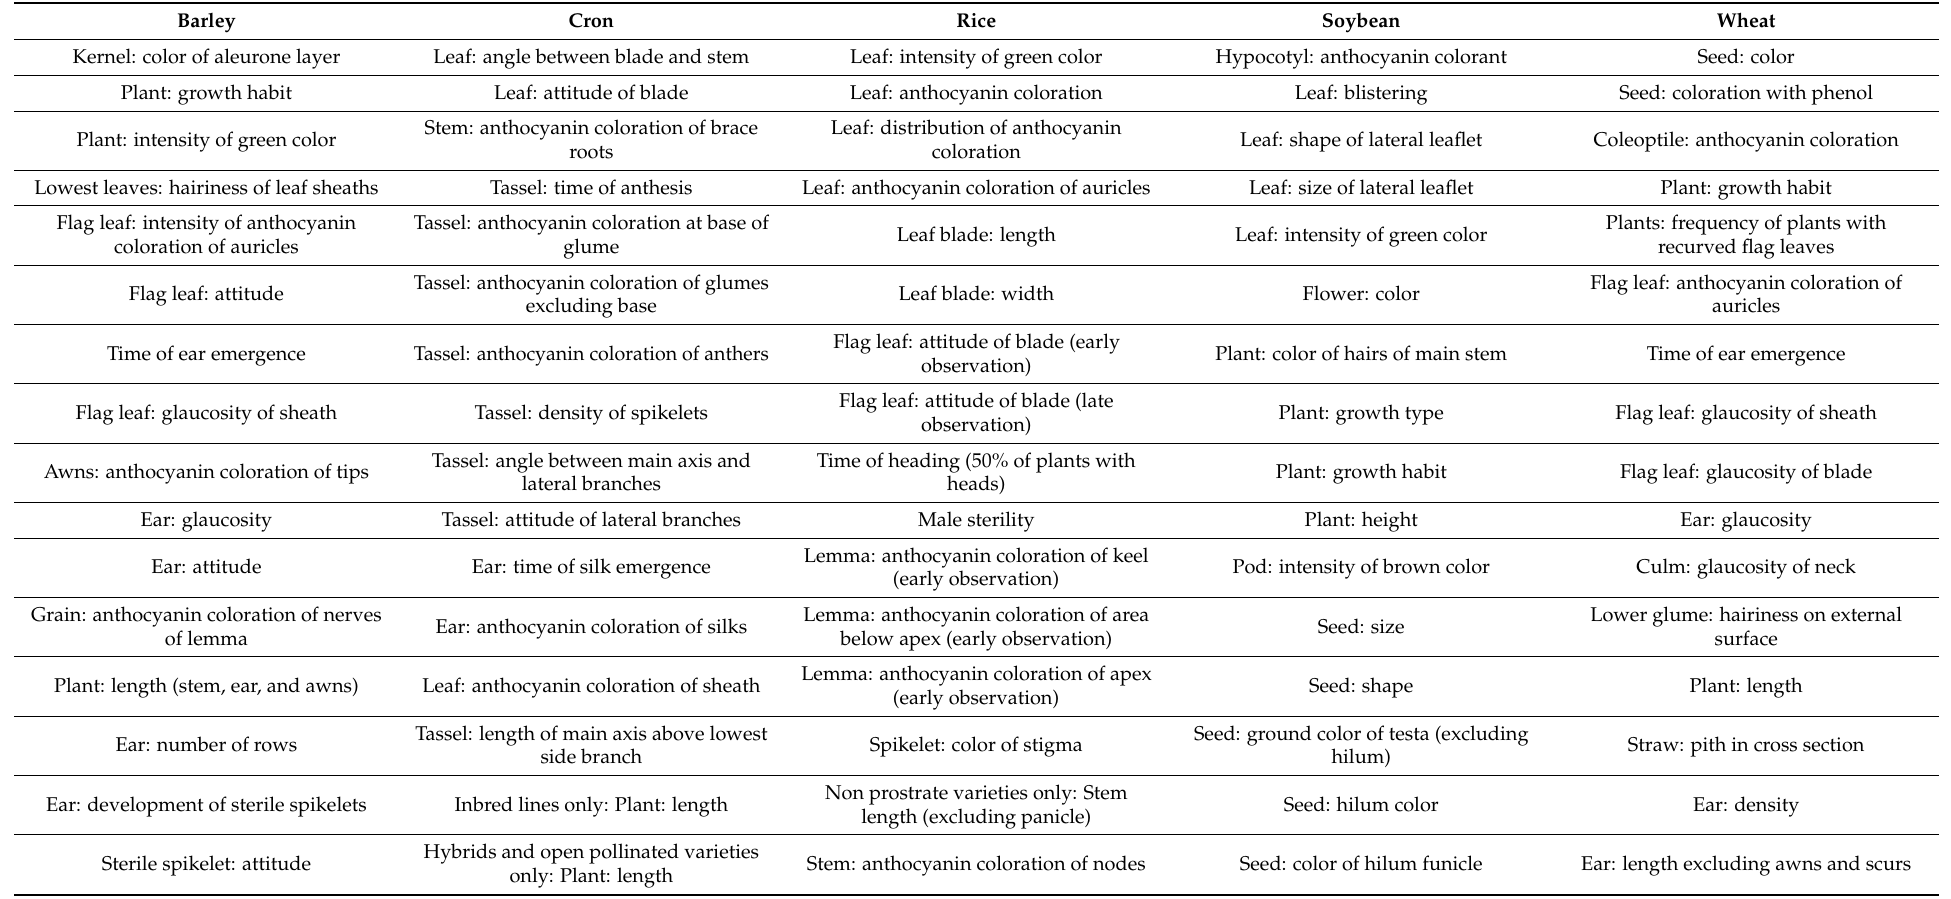
Table 1. The list of DUS traits required by UPOV convention: barley, corn, rice, soybean, and wheat as examples. Barley Cron Rice Soybean Wheat Kernel: color of aleurone layer Leaf: angle between blade and stem Leaf: intensity of green color Hypocotyl: anthocyanin colorant Seed: color Plant: growth habit Leaf: attitude of blade Leaf: anthocyanin coloration Leaf: blistering Seed: coloration with phenol Stem: anthocyanin coloration of brace Leaf: distribution of anthocyanin Leaf: shape of lateral leaflet Coleoptile: anthocyanin coloration Plant: intensity of green color roots coloration Lowest leaves: hairiness of leaf sheaths Tassel: time of anthesis Leaf: anthocyanin coloration of auricles Leaf: size of lateral leaflet Plant: growth habit Plants: frequency of plants with Flag leaf: intensity of anthocyanin Tassel: anthocyanin coloration at base of Leaf blade: length Leaf: intensity of green color recurved flag leaves coloration of auricles glume Flag leaf: anthocyanin coloration of Tassel: anthocyanin coloration of glumes Flag leaf: attitude Leaf blade: width Flower: color auricles excluding base Flag leaf: attitude of blade (early Plant: color of hairs of main stem Time of ear emergence Time of ear emergence Tassel: anthocyanin coloration of anthers observation) Flag leaf: attitude of blade (late Plant: growth type Flag leaf: glaucosity of sheath Flag leaf: glaucosity of sheath Tassel: density of spikelets observation) Tassel: angle between main axis and Time of heading (50% of plants with Plant: growth habit Flag leaf: glaucosity of blade Awns: anthocyanin coloration of tips lateral branches heads) Ear: glaucosity Tassel: attitude of lateral branches Male sterility Plant: height Ear: glaucosity Lemma: anthocyanin coloration of keel Pod: intensity of brown color Culm: glaucosity of neck Ear: attitude Ear: time of silk emergence (early observation) Grain: anthocyanin coloration of nerves Lemma: anthocyanin coloration of area Lower glume: hairiness on external Ear: anthocyanin coloration of silks Seed: size of lemma below apex (early observation) surface Lemma: anthocyanin coloration of apex Plant: length (stem, ear, and awns) Leaf: anthocyanin coloration of sheath Seed: shape Plant: length (early observation) Tassel: length of main axis above lowest Seed: ground color of testa (excluding Ear: number of rows Spikelet: color of stigma Straw: pith in cross section side branch hilum) Non prostrate varieties only: Stem Ear: development of sterile spikelets Inbred lines only: Plant: length Seed: hilum color Ear: density length (excluding panicle) Hybrids and open pollinated varieties Sterile spikelet: attitude Stem: anthocyanin coloration of nodes Seed: color of hilum funicle Ear: length excluding awns and only: Plant: length